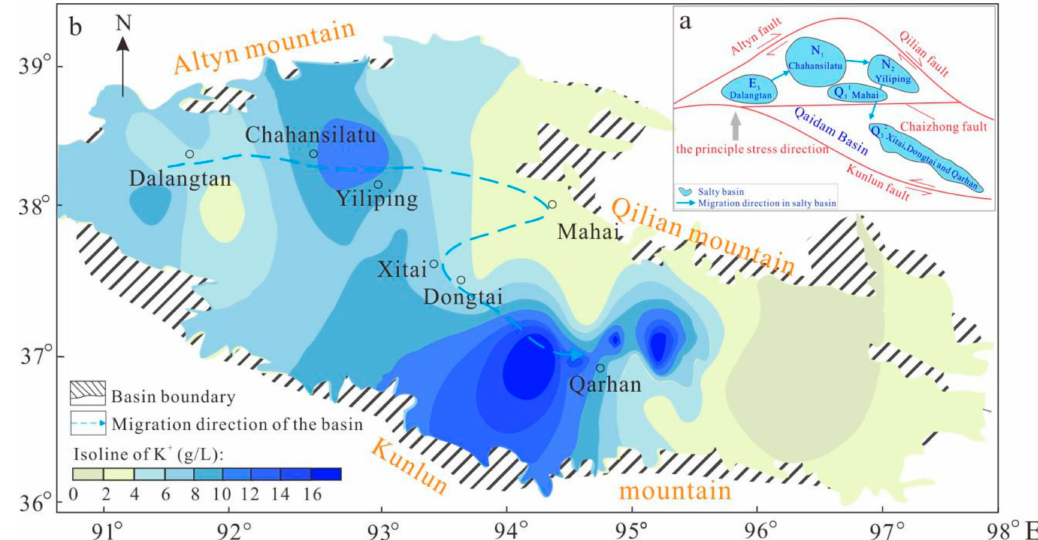
Figure 7. The evolution of salt lakes and the contours of K in salt lake brines in the QB: ( a ) the migration of the salt basins presents a reverse–S shape [8]; ( b ) the distribution of K + in the salt lake brines does not follow the reverse–S evolution path (data from Table 1 and Table